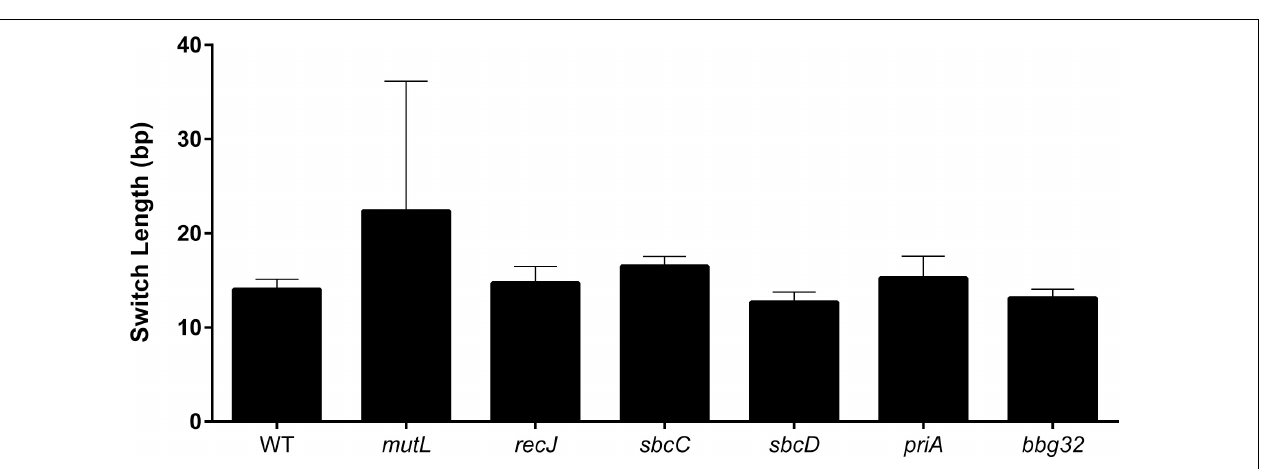
FIGURE 3 | Length of recombination tracts in strains with mutant replication/recombination/repair genes. Recombination tracts were inferred by minimizing the number of recombination tracts required to explain the SNPs of a given read as previously described (Verhey et al., 2018b). The minimum length of each recombination tract is shown as the mean ± SEM for vlsE sequences at 5 weeks